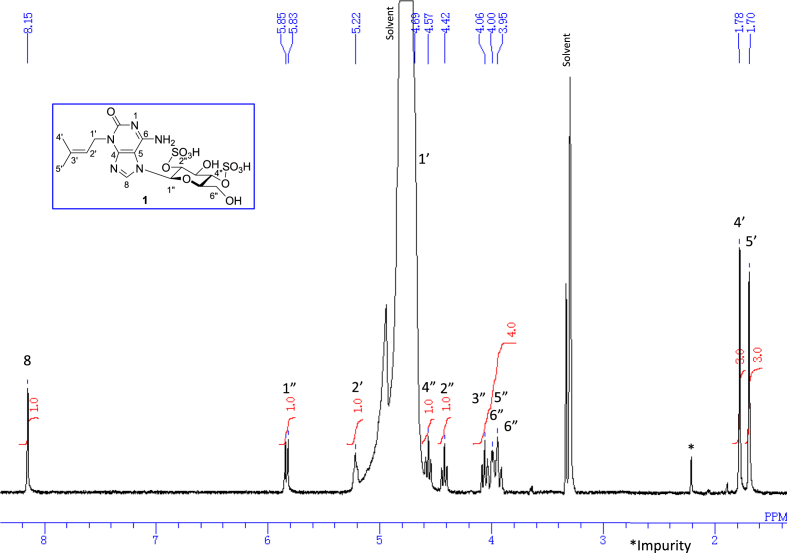
1H NMR (400 MHz, CD3OD–D2O, 1:9) of 1.